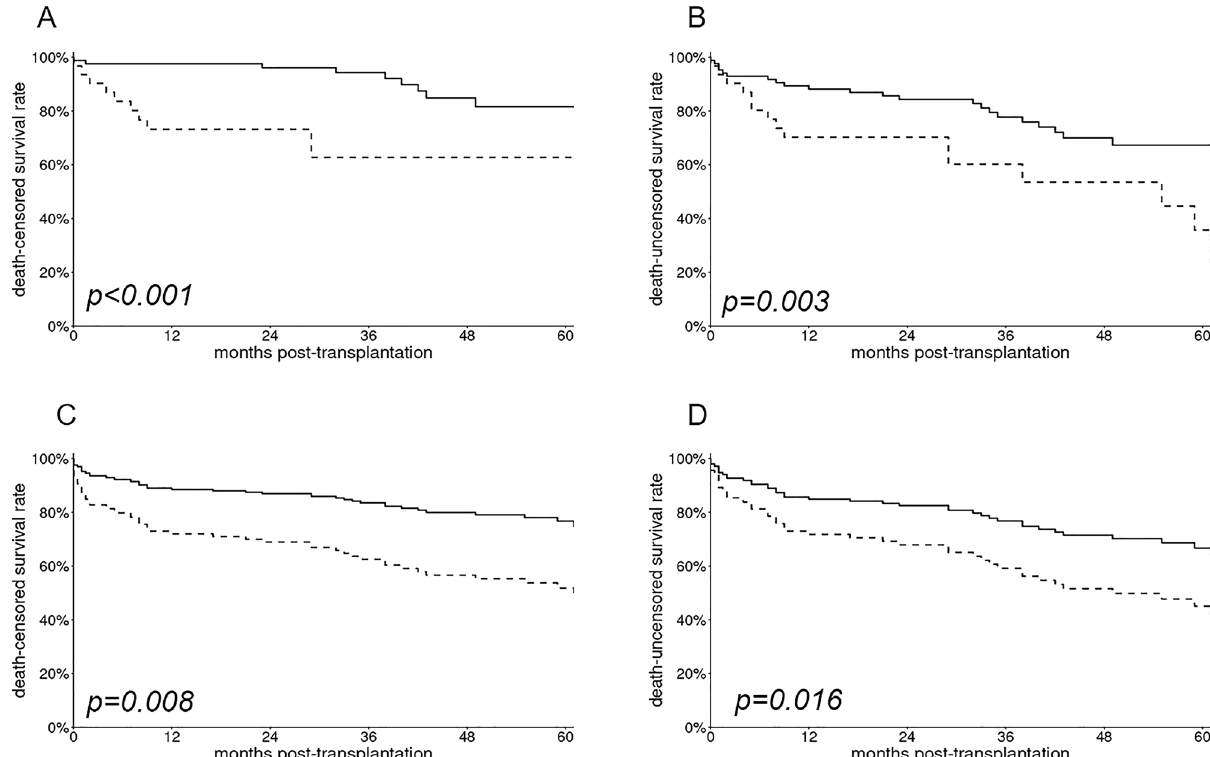
Figure 1. Graft survival rates: non-adjusted survival rates death-censored ( A ) and death-uncensored ( B ) and adjusted graft survival rate, death-censored ( C ) and death-uncensored ( D ). ( C ) Adjustment for post-transplant hematoma, acute rejection, BK virus nephropathy and BMI. ( D ) Adjustment for post-transplant hematoma and urinoma, acute rejection and BK virus nephropathy. Bold line = donor impaired renal function group. Dashed line = no donor impaired renal function group. Donor renal failure was defined as a donor with a serum creatinine over 1.0 mg/dl or with a transient oligo-anuria before organ procurement. p-values for non-adjusted curves were defined according to the log-rank test. p-values for adjusted curves were defined according to the Cox model